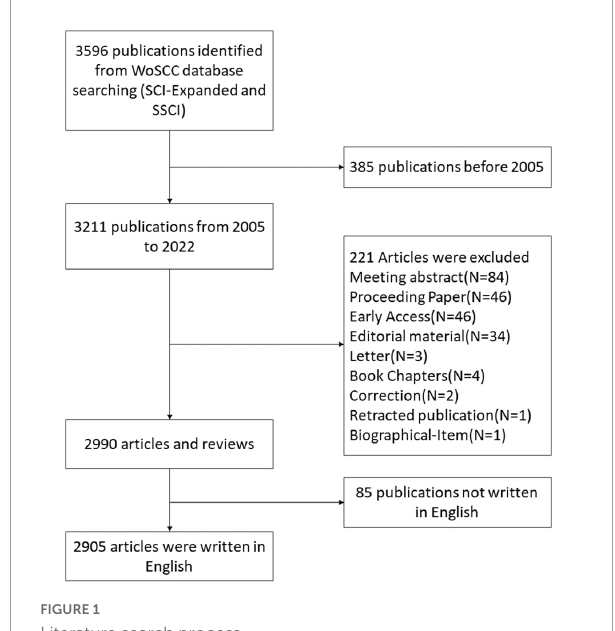
FIGURE1 Literature search